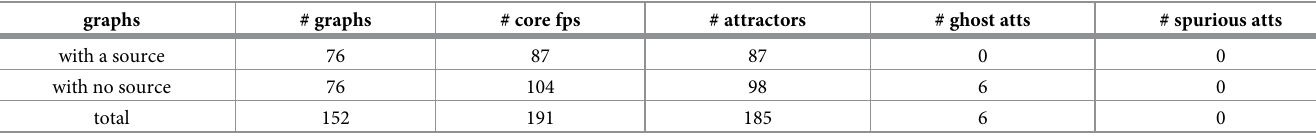
Table 2. Core fixed points and attractors for n = 5 oriented graphs with no sinks. The attractors were found in CTLNs with the standard